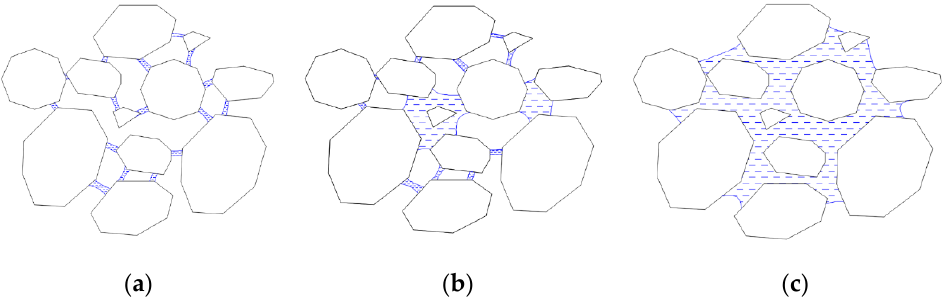
Figure 12. Liquid bridge regimes in unsaturated and saturated tailings: ( a ) pendular; ( b ) funicular; ( c ) capillary.